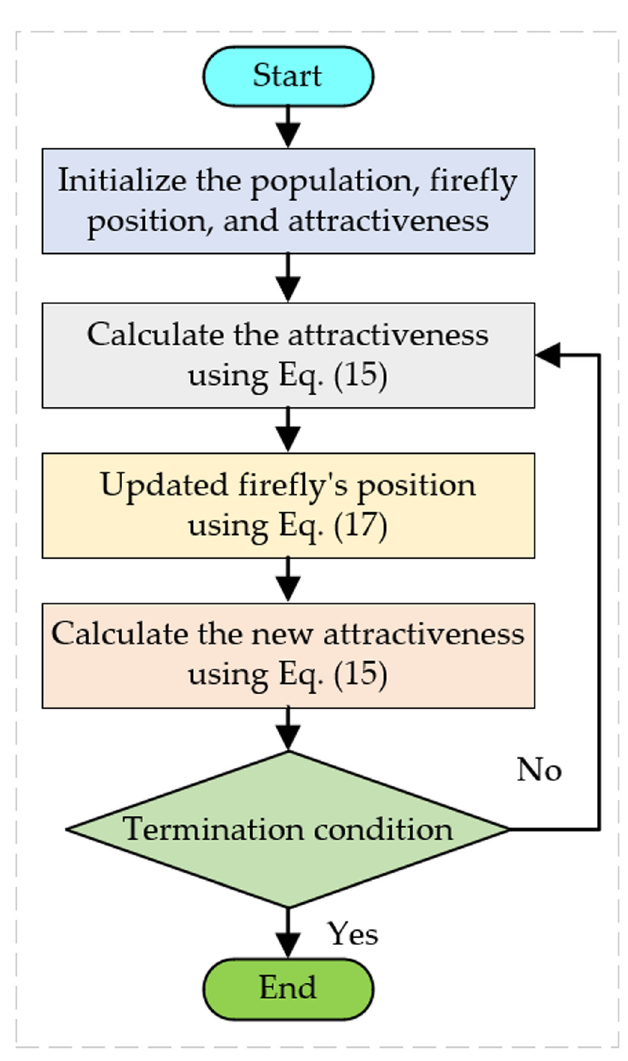
Fig. 3. The fl owchart of the